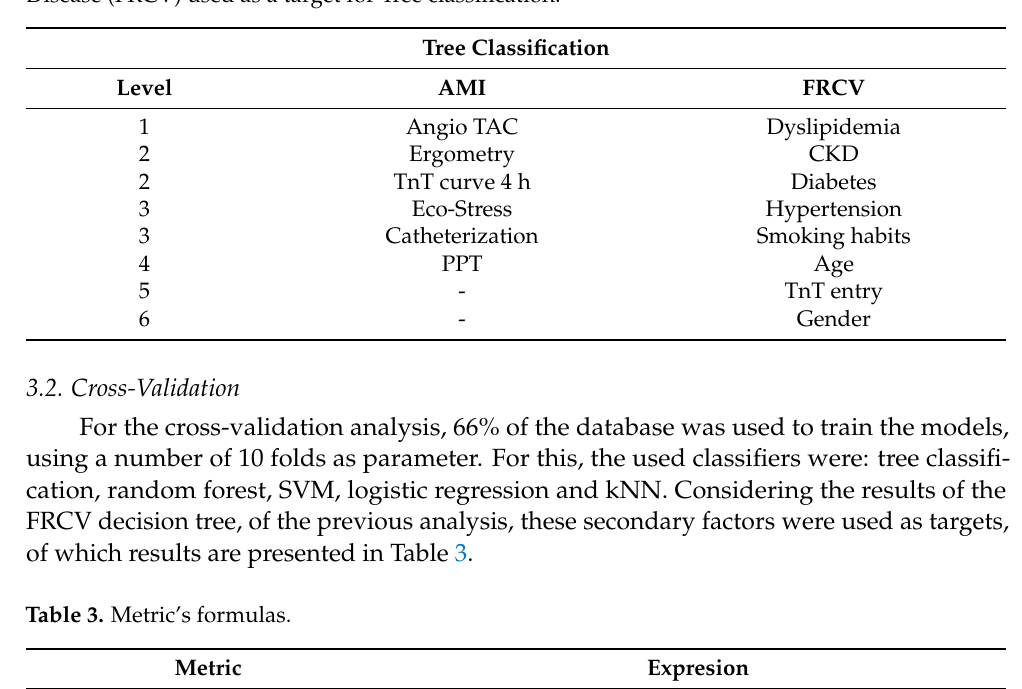
Table 2. Comparison between Acute Myocardial Infarction (AMI) and Risk Factors for Cardiovascular Disease (FRCV) used as a target for Tree classification.